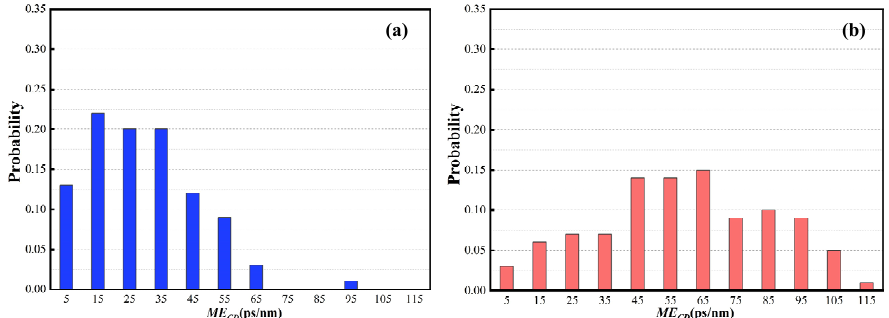
Figure 4. Distribution of the mean value of the absolute CDE error using 4096 samples when the step size of the order scanning and the granularity of the CD scanning are ( a ) 0.002 and 100 ps/nm, and ( b ) 0.004 and 200 ps/nm.